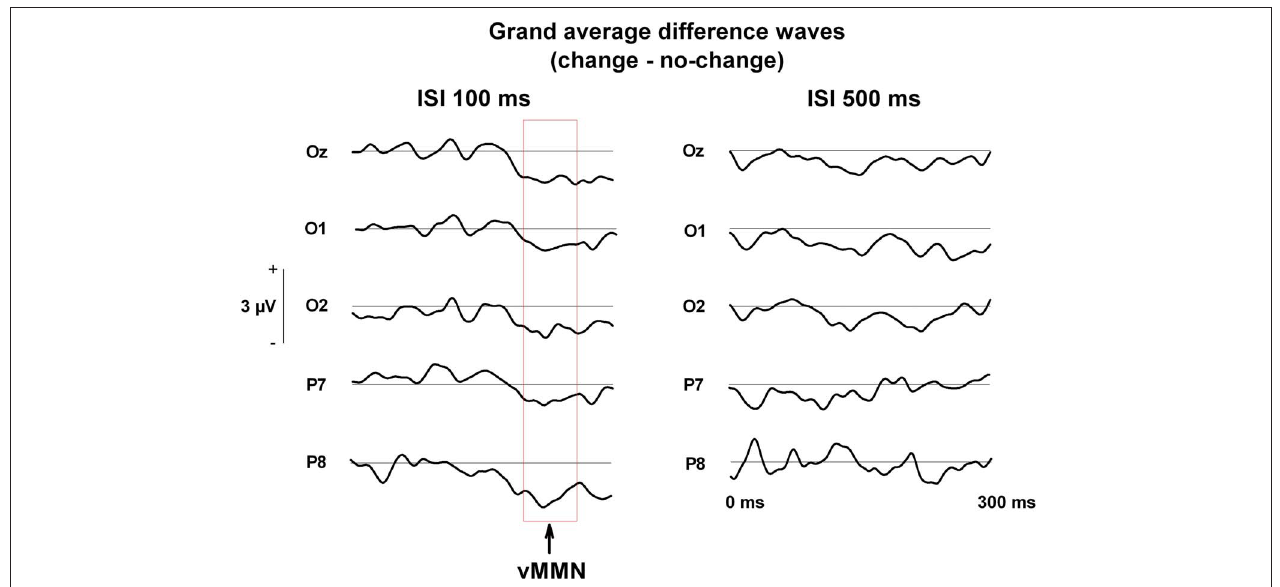
FIGURE 2 | Grand averaged difference waves (change—no change) during change blindness running from stimulus onset (0ms) to 300ms post-stimulus.